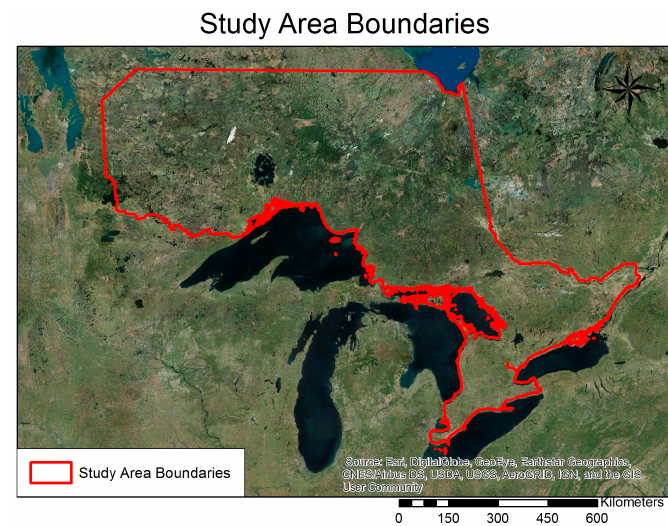
Figure 1. The study area boundaries delineate the region of Ontario included for analysis. The northern boundary is defined by row 840 in the MODIS11C3 data, which encompassed all of southern Ontario and part of northern Ontario that coincided with ticks collected and submitted to Public Health Ontario.